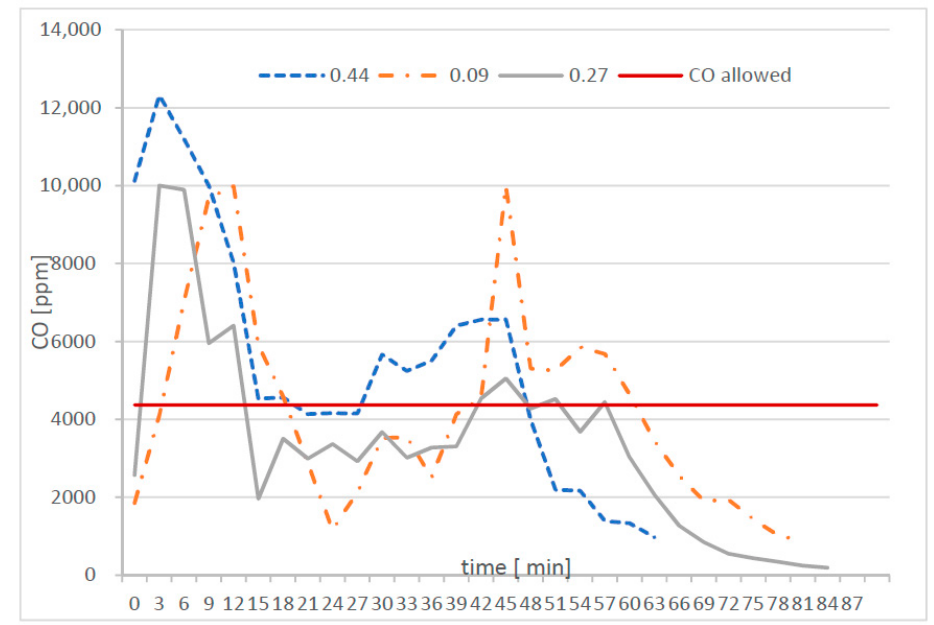
Figure 7. CO emission evolution for each flow rate.